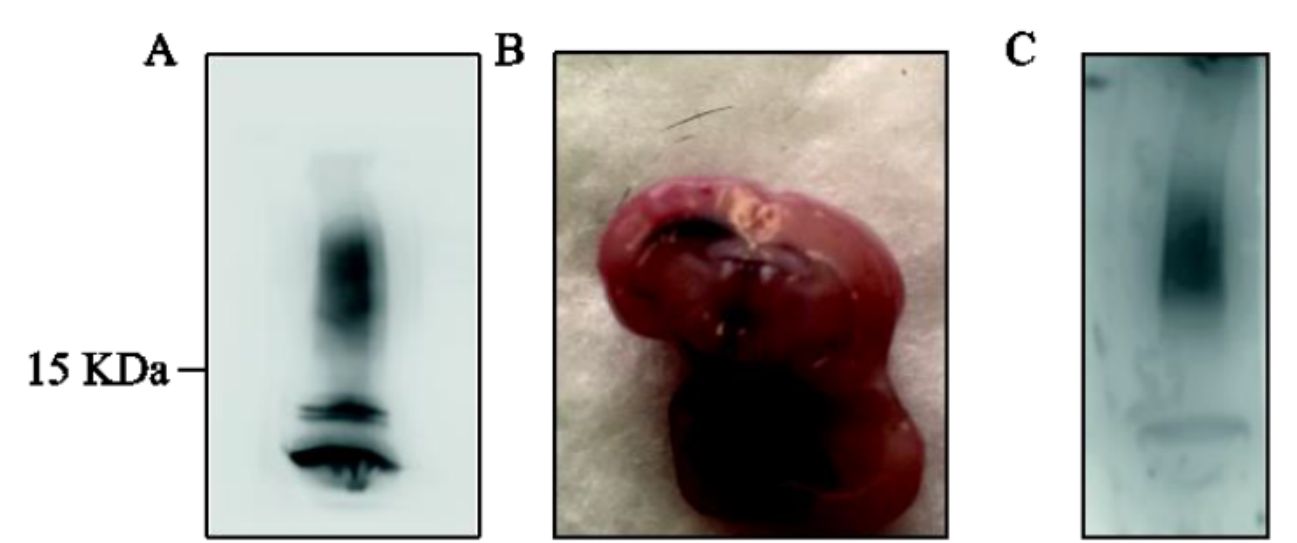
Figure 4. ( A ) Immunoblot with anti-b-amyloid antibody (Biolegend SIG-3920) showed small-sized A β monomer, dimer and tetramer bands. A β was aggregated for 24 h at 37 °C. ( B ) The effective distribution of the injected solution (methylene blue). ( C ) Immunoblot with anti-b-amyloid antibody (Biolegend SIG-3920) on hippocampal protein extracts after 1 week of A β i.c.v. injection showed the A β in the mouse brain. Results are representative of three different injections.